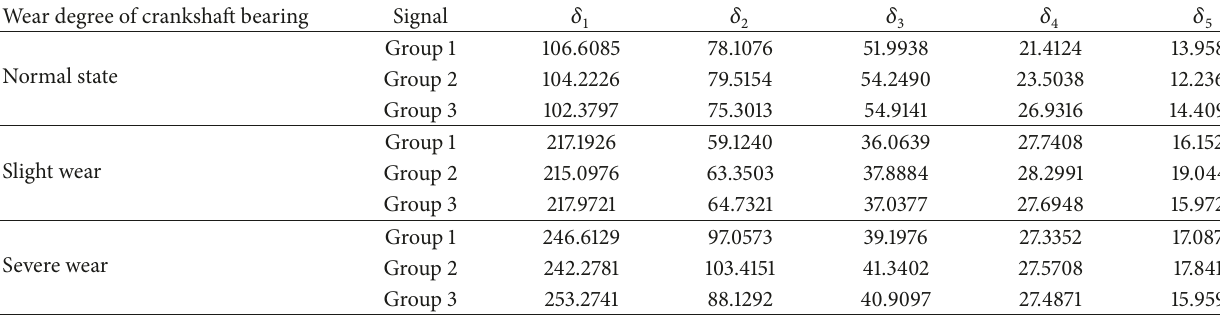
Table 3: Detection sample.